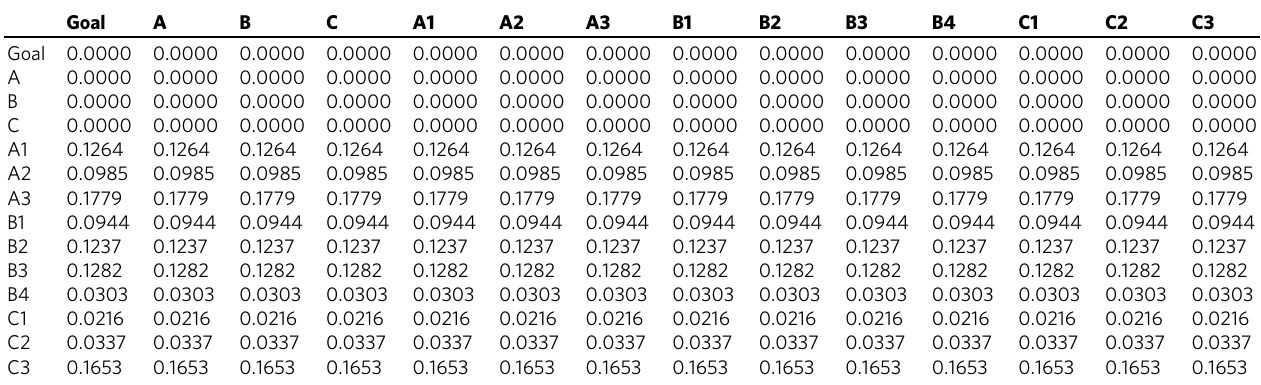
Table 10 The limit supermatrix.